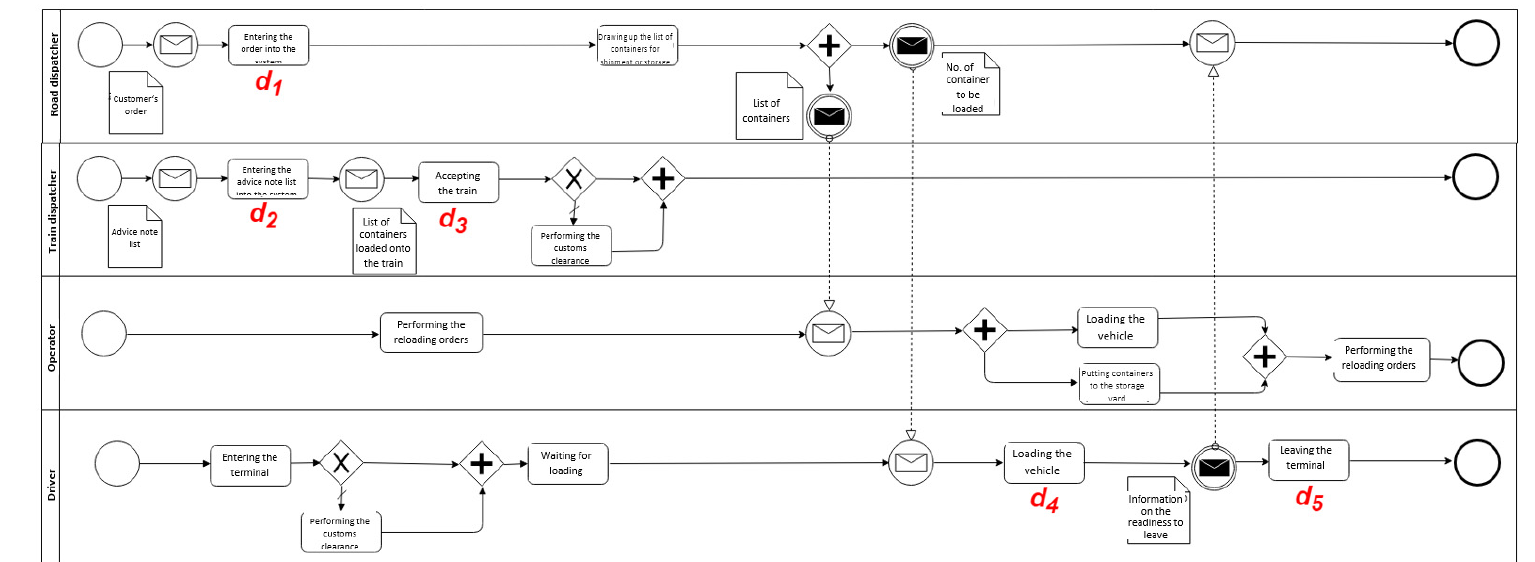
Figure A1. Flow chart of the selected process.